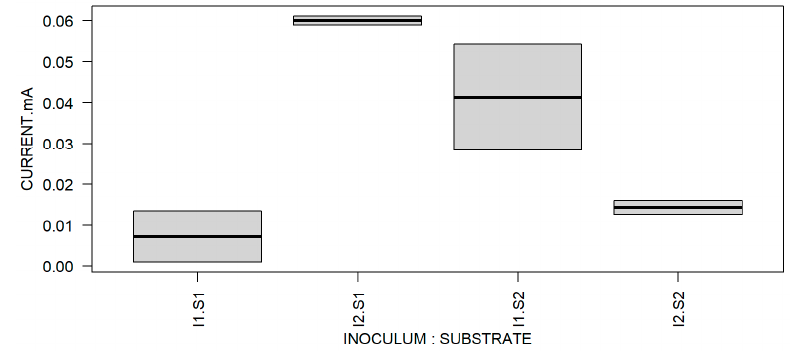
Figure 14. Results of LSD–Tukey’s tests.